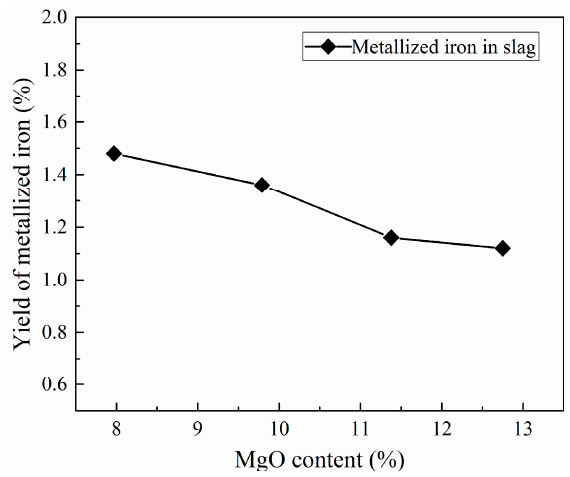
Figure 15. Effect of MgO content on yield of residual metallized iron in slag. Table 3. Production index of vanadium-bearing iron. Element Grade in Iron (wt.